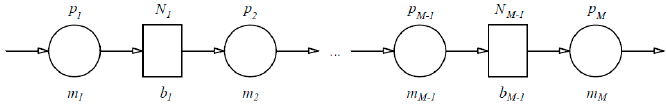
Figure 1. Bernoulli serial line [10].